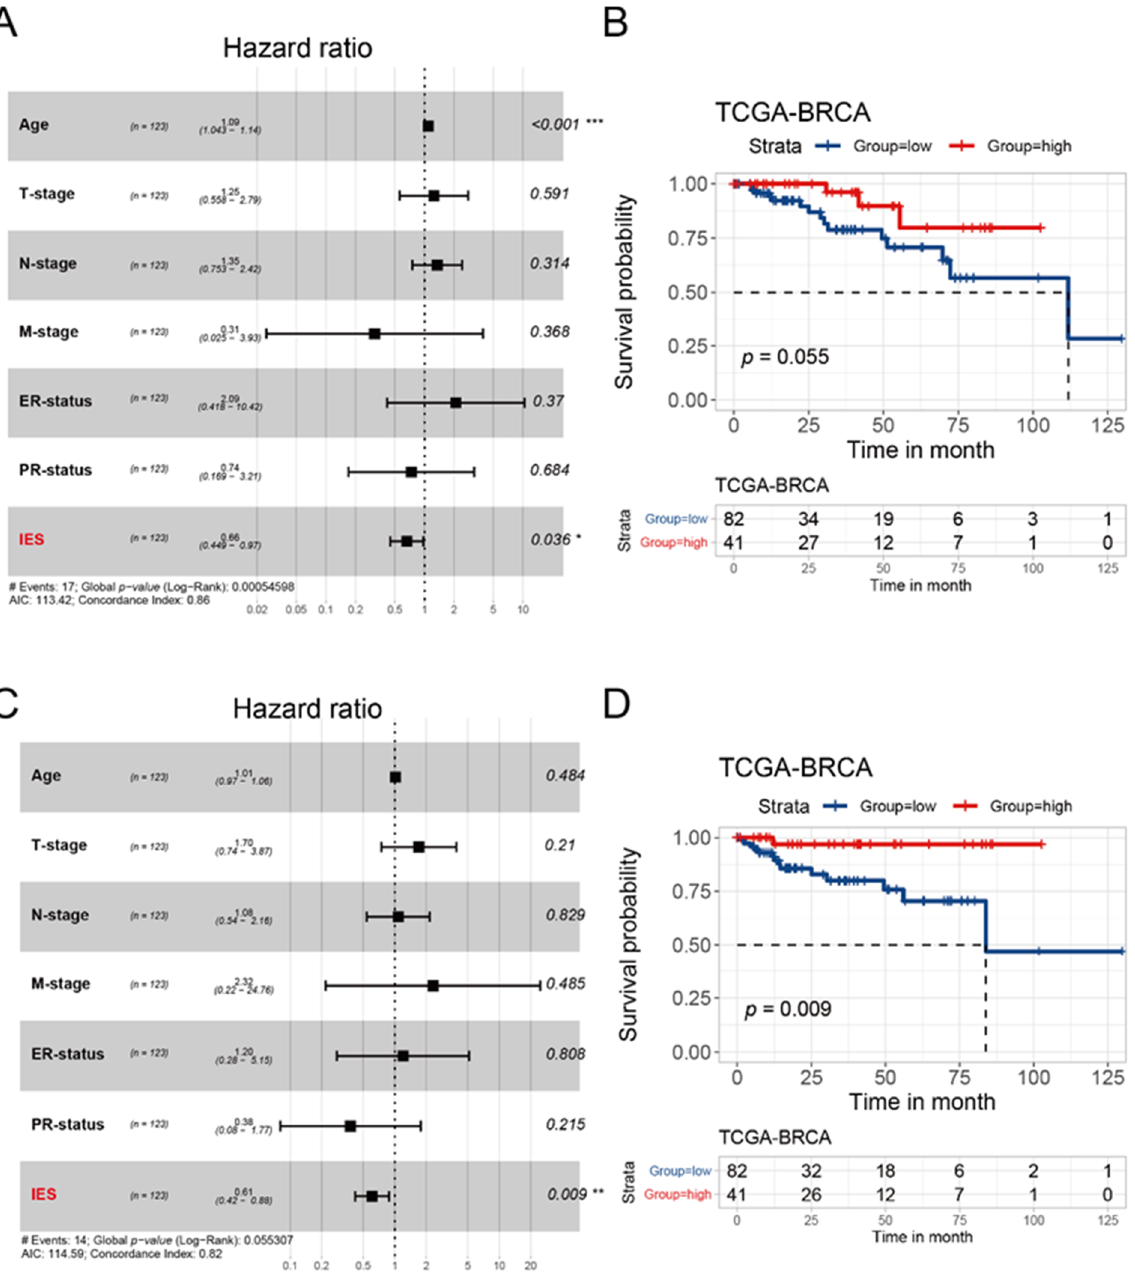
Figure 4. Prognostic analysis of the IES in the TCGA cohort. Forest plots of multivariate Cox proportional hazards regression analysis of OS ( A ) and PFI ( C ) in the TCGA cohort. The p values was calculated by Cox regression (* p < 0.05, ** p < 0.01, *** p < 0.001). OS: overall survival; PFI: progression- free interval. Kaplan–Meier survival curves show the OS ( B ) and PFI ( D ) stratified by low/high-IES in the TCGA cohort. The p values were obtained by the log-rank